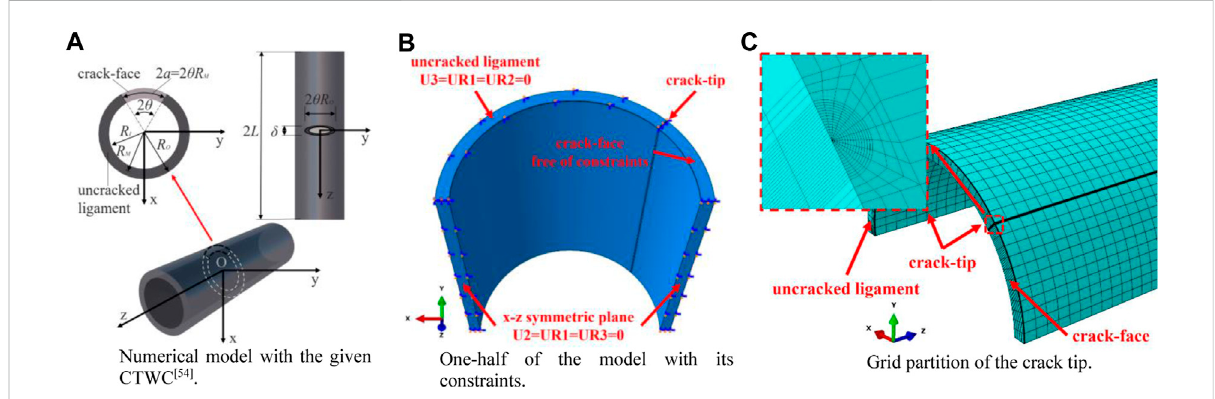
FIGURE 1 Numerical model. (A) Size parameters in numerical model. (B) One-half of the model with its constraints. (C) Grid partition of the crack